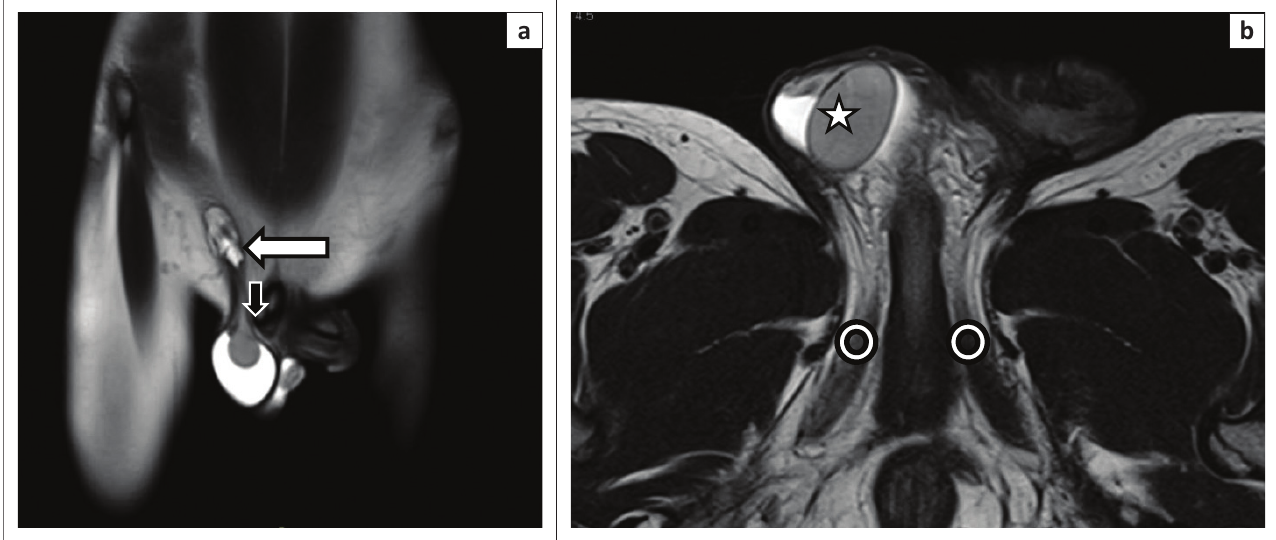
FIGURE 5: (a) Coronal and (b) axial T2-weighted (T2W) magnetic resonance images in 9-month-old male child showing true undescended right testis (star) at the level of the root of penis, near the pubic tubercle (black arrow). The crura of the penis are seen at this level (circles). The inguinal canal (white arrow) is well visualised on coronal